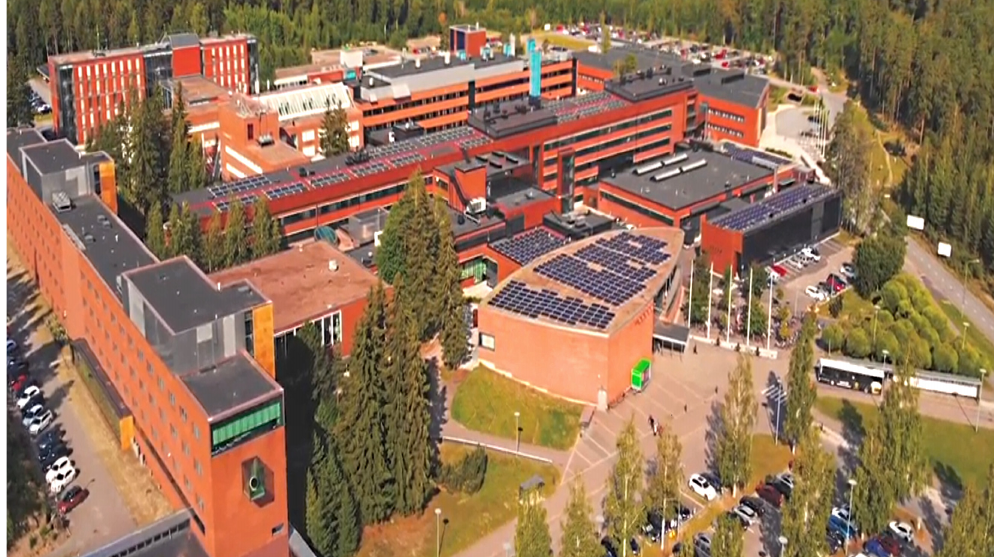
Figure 4. Lappeenranta-Lahti University campus area selected for the